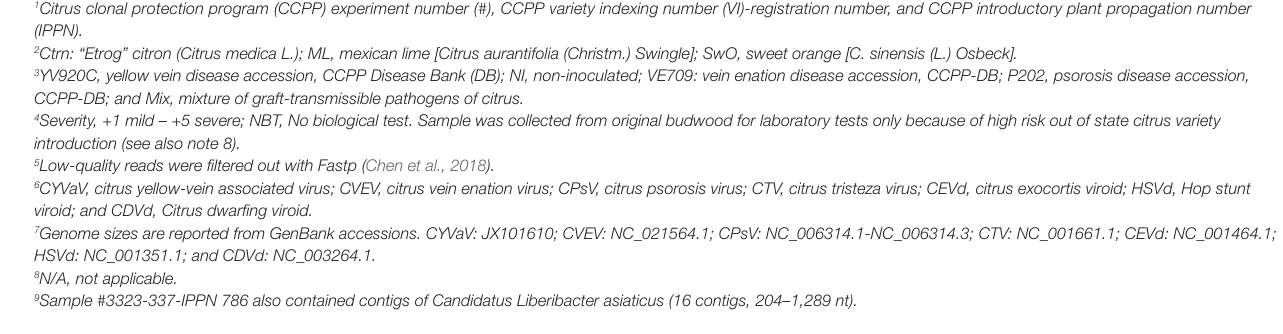
RNA1: 12 (213-1,099) RNA2: 1 (1,617) RNA3: 1